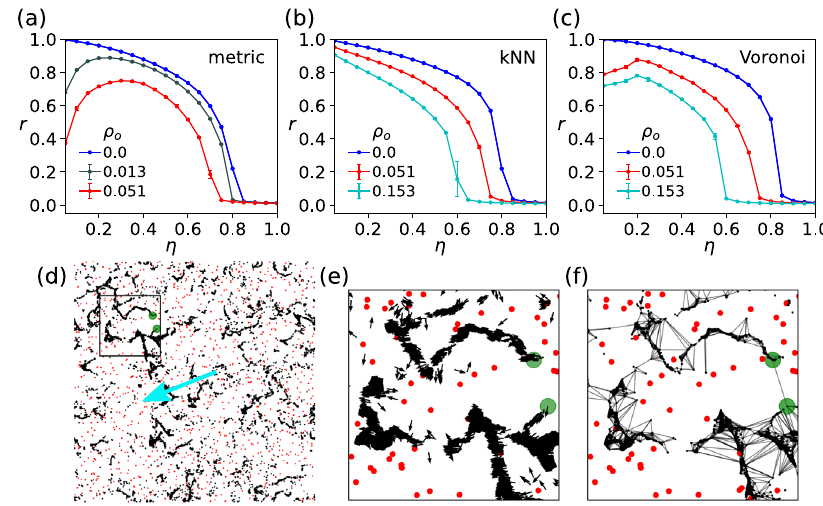
Fig. 3 Disorder to order transition. Polar order parameter r versus noise intensity η at different obstacle densities ρ o for different types of interaction neighborhoods, metric ( a ), k -nearest neighbors ( k NN, k = 6 where k is the number of neighboring objects) ( b ), and Voronoi ( c ). d The snapshot shows a typical con fi guration forming in a system with Voronoi interaction in heterogeneous environments at low noise values, here η = 0.05, and ρ o = 0.051. Black and red dots represent particles and obstacles respectively. The arrow shows the instantaneous polarization of the system. e , f Show magni fi cation of the region displayed in ( d ). In e , black arrows show the particles' instantaneous moving direction. In f the underlying (undirected) Voronoi interaction network is depicted. A link exists between two particles, if they are neighbors in the Voronoi tessellation, and if at least one of them does not have an obstacle in its neighborhood. The green circles point out clusters that are connected by long links, i.e., long-distance interactions. Error bars represent the standard deviation of the polar order parameter over different realizations of the obstacle fi eld (see “ Methods ” ). Note that error bars are often comparable or smaller than the symbol